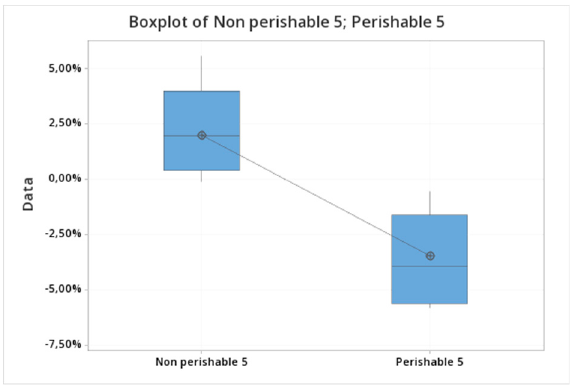
Figure 12. Boxplot CAARs event window E ( − 5,+5) .